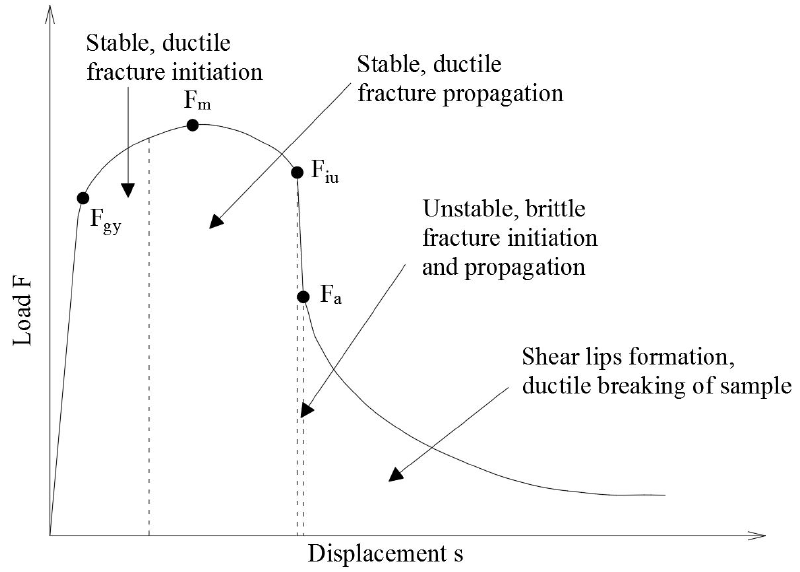
Figure 1. Theoretical 𝐹 − 𝑠 curve obtained during the impact notch-toughness test of steel specimens exhibiting mixed fracture.